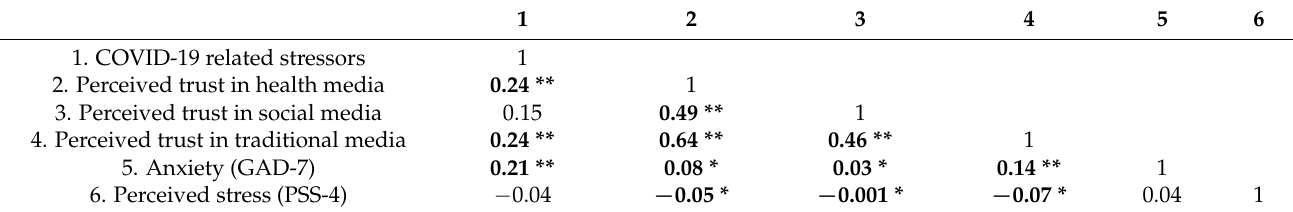
Table 3. Bivariate correlations between study variables ( n = 744).